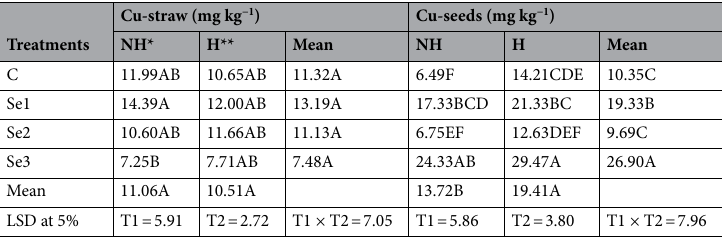
Table 12. Effects of Se and K-humate application on Cu content. *Refers to Se application without K-humate. **Refers to the simultaneous application of Se and K-humate.